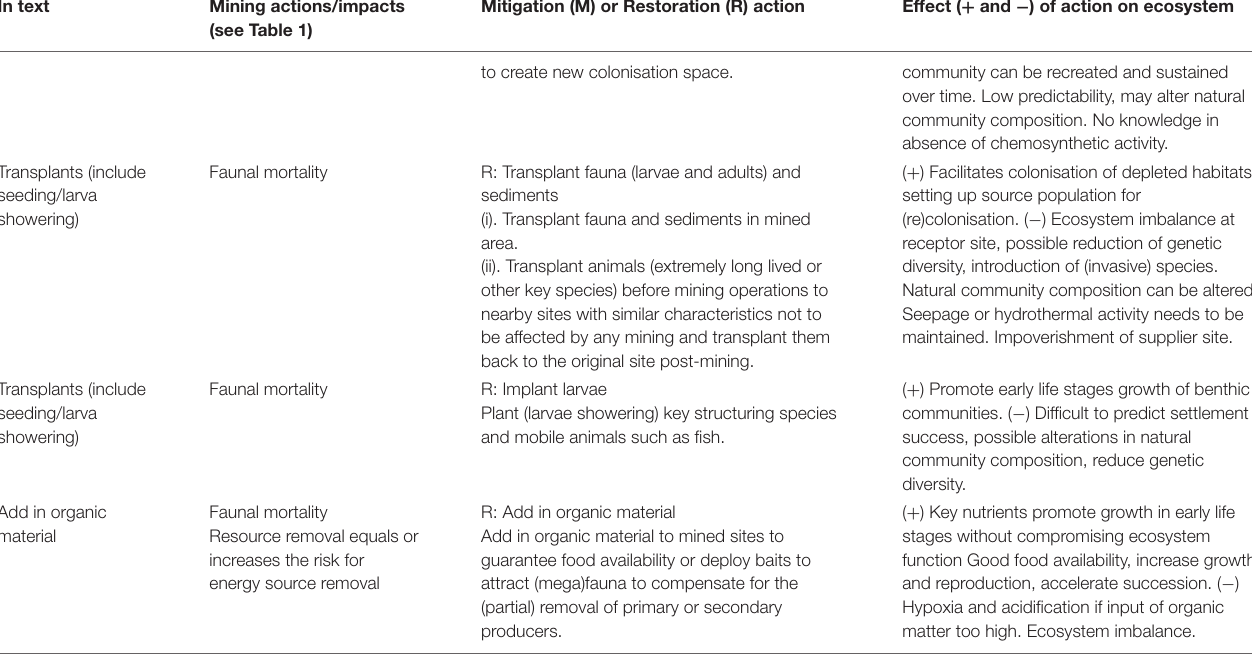
(Incorporated Society of British Advertisers [ISBA], 2007; Tilot, 2010; Wedding et al.,